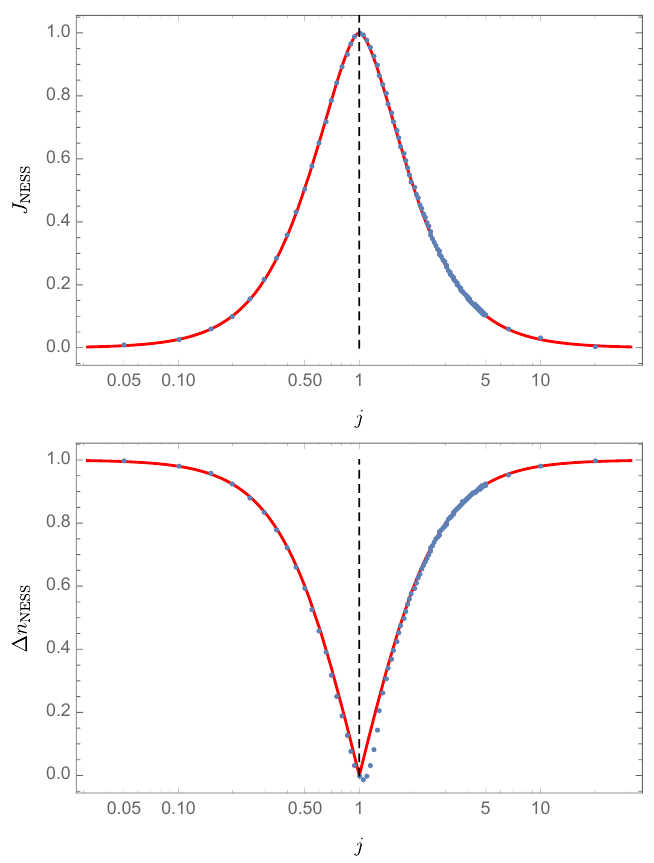
Figure 4: Log-linear plots of the NESS current at the origin J sity difference far on the left and on the right from the defect ∆ n functions of the defect strength j (ratio of defect over bulk hopping). Current and density units are − 4 µ/π and 2 µ respectively, with 2 µ the size of the initial density step. Analytical results (red curves) given by (39) and (44) vs. estimates extracted from numerics (blue